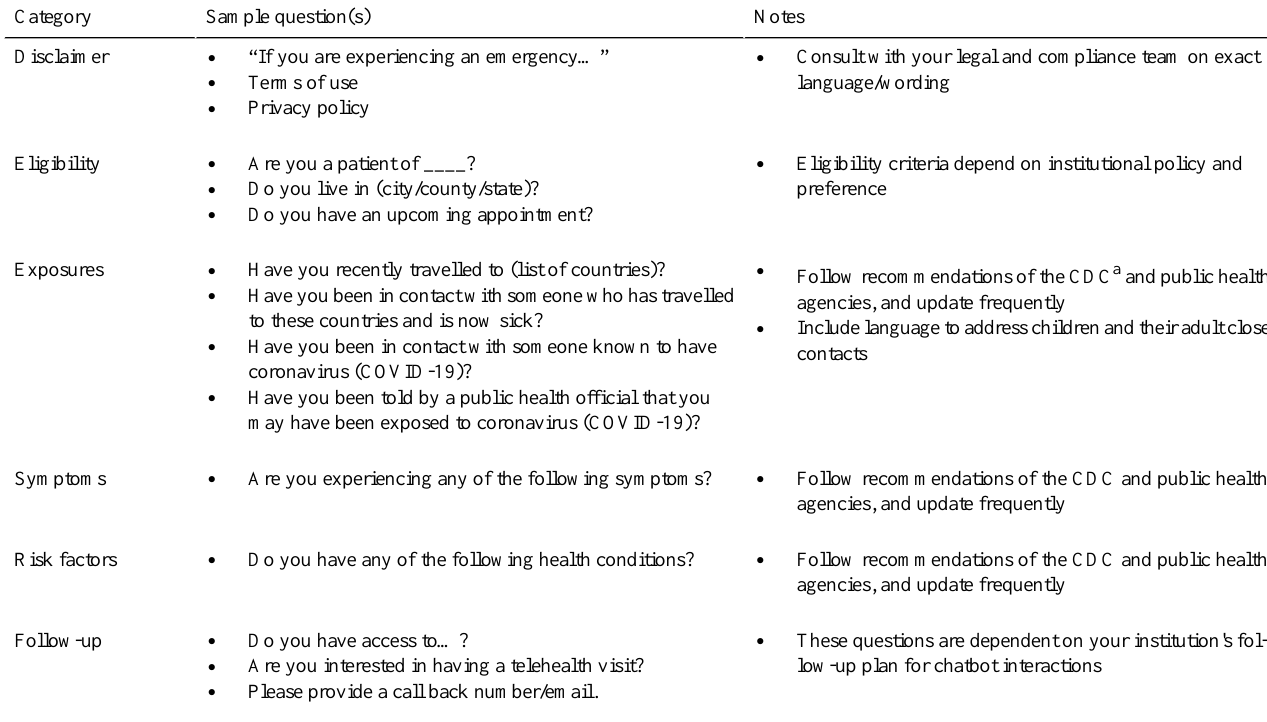
Table 1. Chatbot question